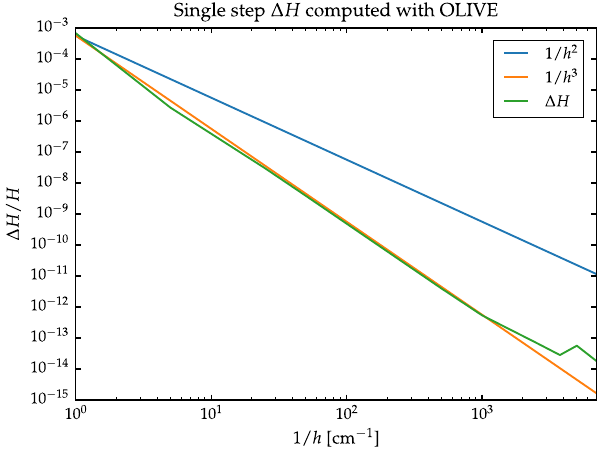
FIG. 5. The change in Hamiltonian evaluated after a single step reveals 2nd order scaling with step size h .